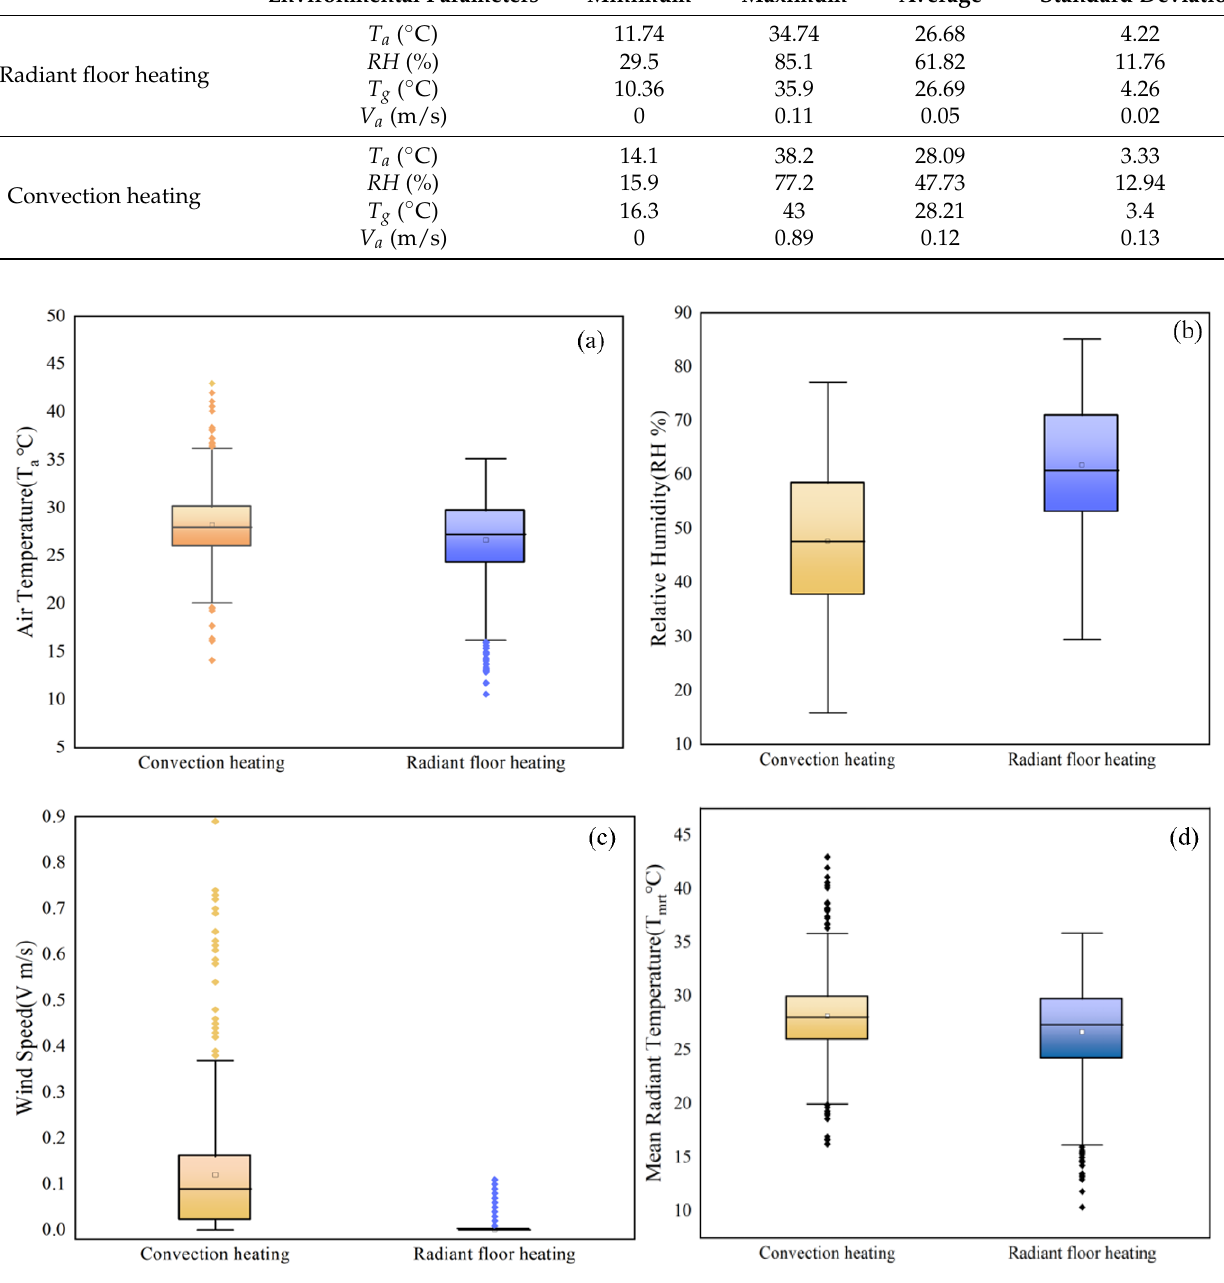
Figure 4. Indoor thermal parameter distribution: ( a ) air temperature, ( b ) relative humidity, ( c ) air velocity, and ( d ) mean radiant